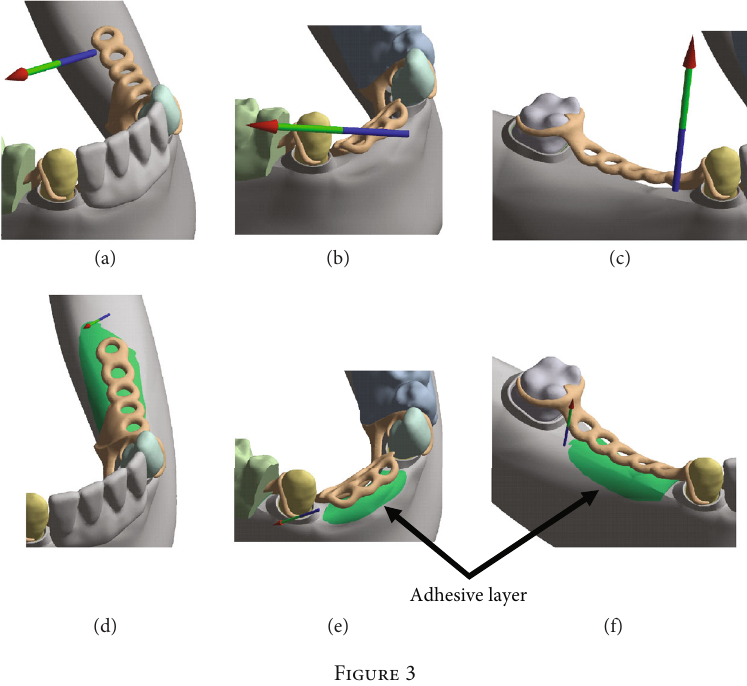
Table 3: Summary of the reaction forces on the major contact spaces in the assembly due to the applied bite force on the right denture segment. Contact space